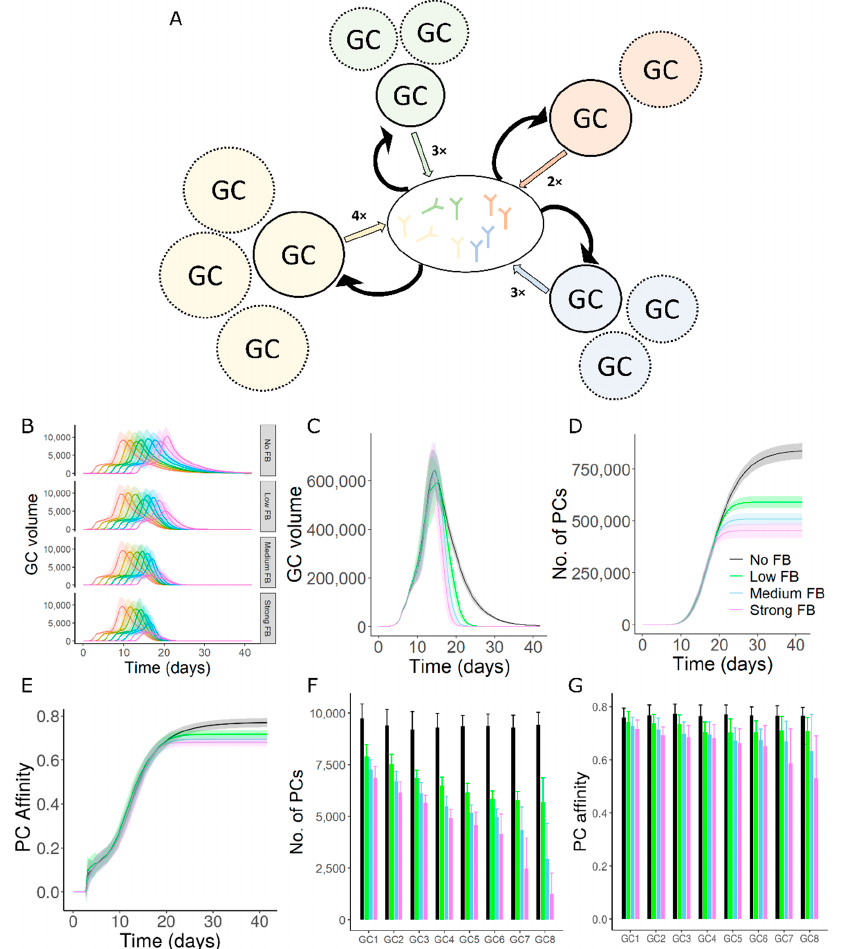
Figure 1. GC–GC interactions limit the magnitude of GC responses. ( A ) Schematic representation of GC–GC interactions in a multi-GC agent-based model. Colored arrows represent the production of soluble antibodies from individual GCs. Black arrows represent the feedback of soluble antibodies on simulated GCs. Solid circles represent simulated GCs and dotted circles show non-explicitly simulated GCs represented by every simulated GC. n in n× is the number of synchronous GCs to account for the antibody contribution of non-explicitly simulated GCs. Values of n shown in this figure are chosen for representation purpose only. See methods for values used in simulations. ( B ) Volume kinetics of simulated GCs. GCs were initialized asynchronously, and color code represents the timing of GC initiation. ( C ) Total volume of all GCs. ( D ) Plasma cell production from all GCs. ( E ) Affinity of plasma cells from all GCs. Readouts in C-E represent the sum of corresponding readouts of all simulated GCs weighted by the number of non-explicitly simulated GCs in each case. ( F ) Number of plasma cells produced from individual GCs. ( G ) Affinity of plasma cells from individual GCs. GCs 1–8 were sorted in the sequence of initiation. Inset in panel D shows the GC– GC interaction strength (see methods) and applies for panels C-G. A single epitope (shape space position 3333) was considered with founder cell positions chosen randomly anywhere in the shape space.